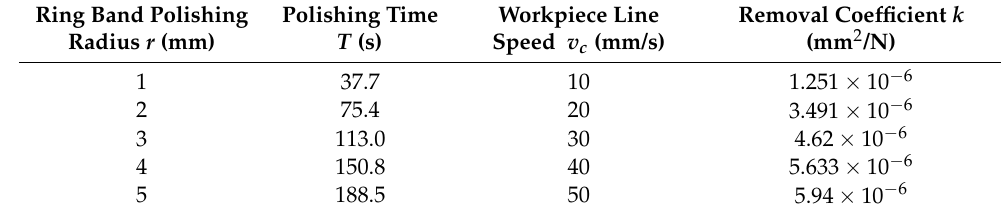
Table 2. Parameters and results of the ring band experiment.